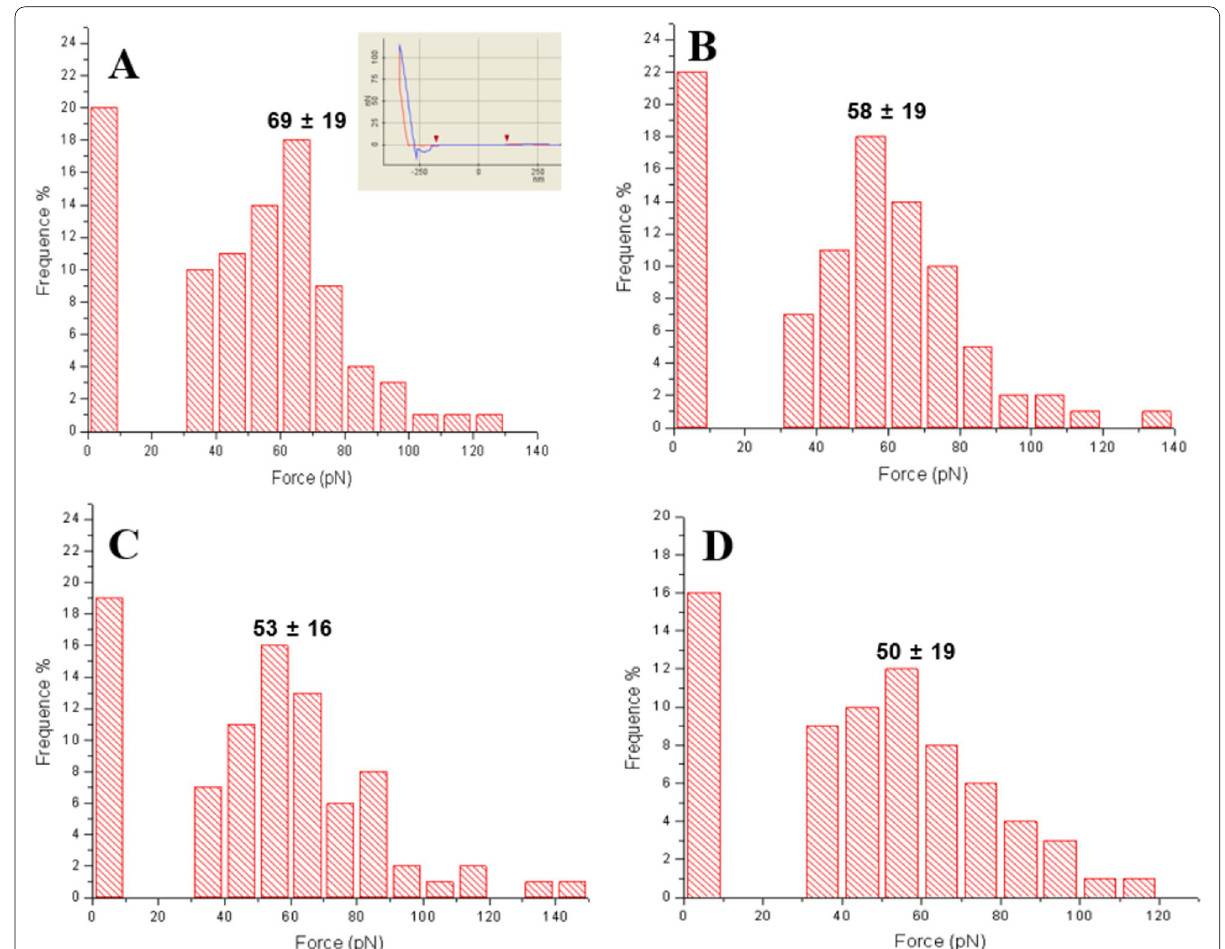
Fig. 3 Measurement of adhesion force using AFM of wild and mutant Cel5H proteins on mica. Adhesion force map for wild-type protein A (Cel5H, gray sclae: 180 pN), adhesion force histogram ( n 226), adhesion force histogram for mutant M2 protein B, adhesion force histogram for M3 protein = C, adhesion force histogram for M4 protein D. All curves were obtained using an approach and retraction speed of 0.5 μm s −